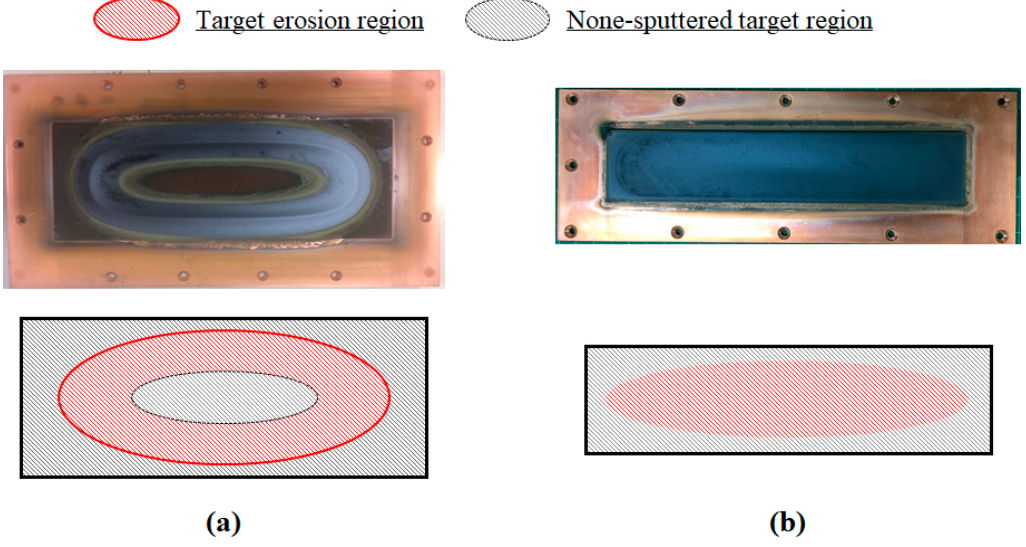
Figure 5. Photo images of the target erosion region for a target erosion ratio. ( a ) Open-type FTS (OFTS) and ( b ) Closed-type FTS (CFTS).